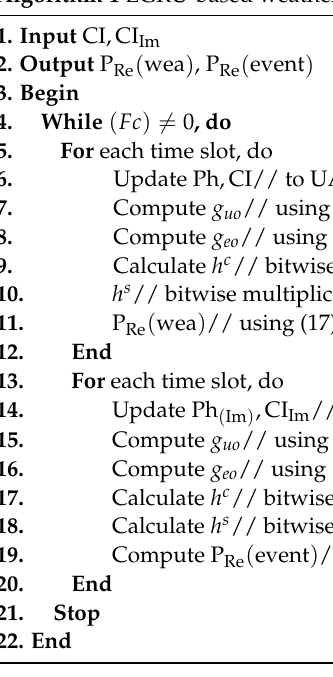
Algorithm 1 LGRU ‐ based weather and event prediction.